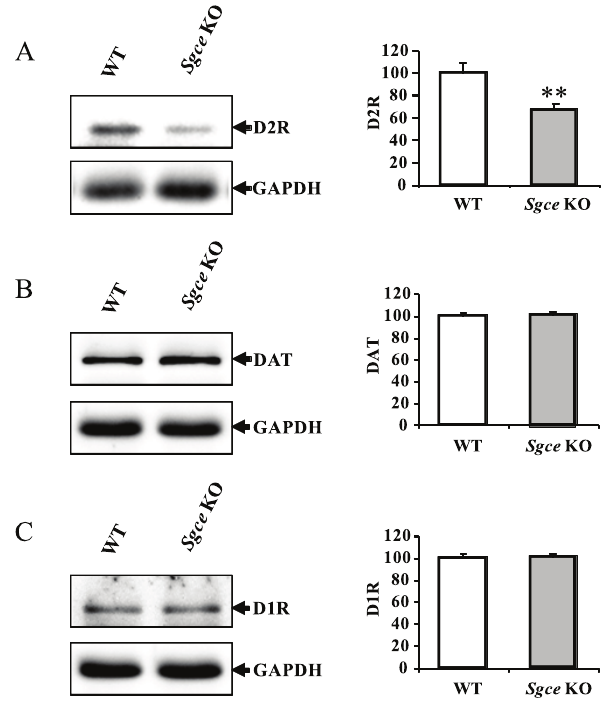
Figure 2. Western blot analysis of striatal D1R, D2R and DAT. Western blot analysis by using the striatal protein extracts from paternally inherited Sgce KO mice and their WT littermates. The representative bands D2R (Fig. 2A), D1R (Fig. 2C), DAT (Fig. 2B), and GAPDH are shown in the left side, and the quantified results are shown in the right side. The vertical bars represent means 6 SEM of 3 or 4 mice (** p , 0.01).